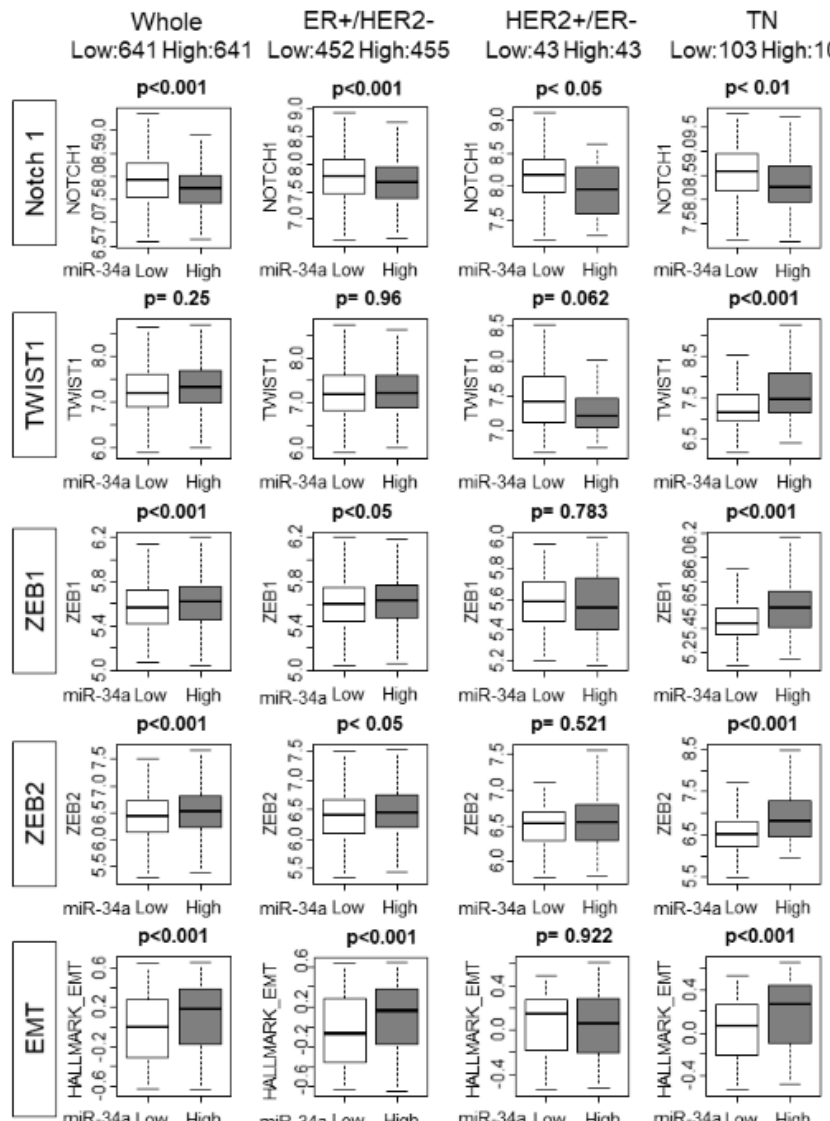
Figure 5. High MiR-34a expression tumors associated with a higher epithelial–mesenchymal transition (EMT) score. Each row has a whole METABRIC cohort, and each subtype. Top row: Notch 1 expression by miR-34a expression. Second row: TWIST 1 expression by miR-34a expression. Third row: ZEB 1 expression by miR-34a expression. Fourth row: ZEB 2 expression by miR-34a. Bottom row: GSVA Hallmark EMT score by miR-34a expression. EMT, epithelial–mesenchymal transition.